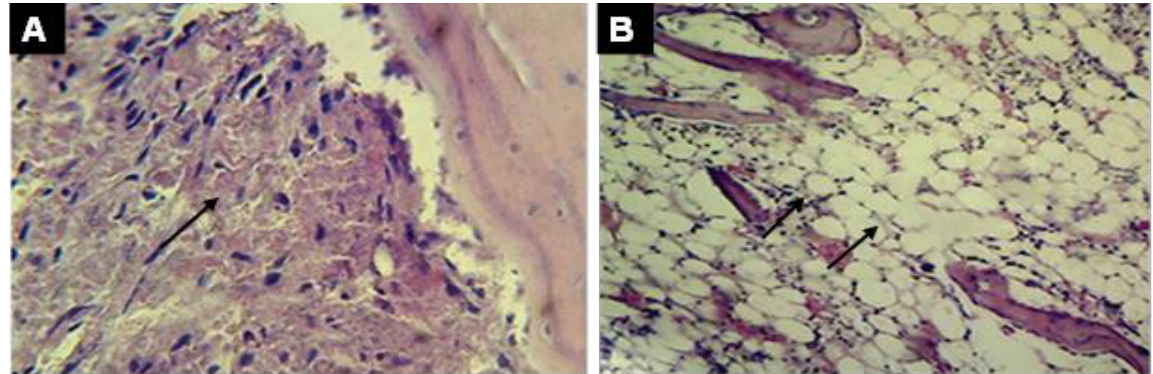
Figure 5. Histopathological section in control group at 4 th weeks PO, (A) granulation tissue extended from the site of fracture infiltrated by inflammatory cells particularly mononuclear cells (arrow) (B) bone trabeculae lined by osteoblast extended into narrow cavity (arrow) (H and E,